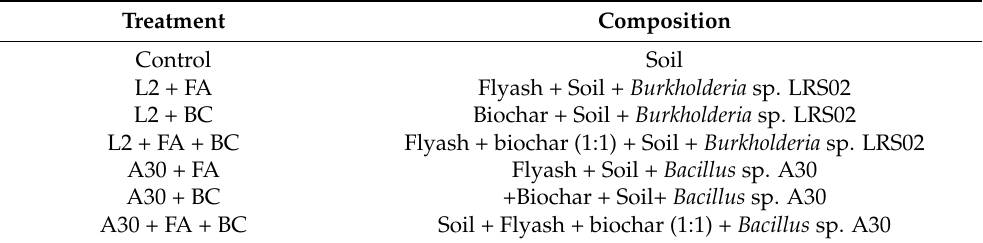
Table 1. Description of treatments used for pot experiments. Treatment Composition